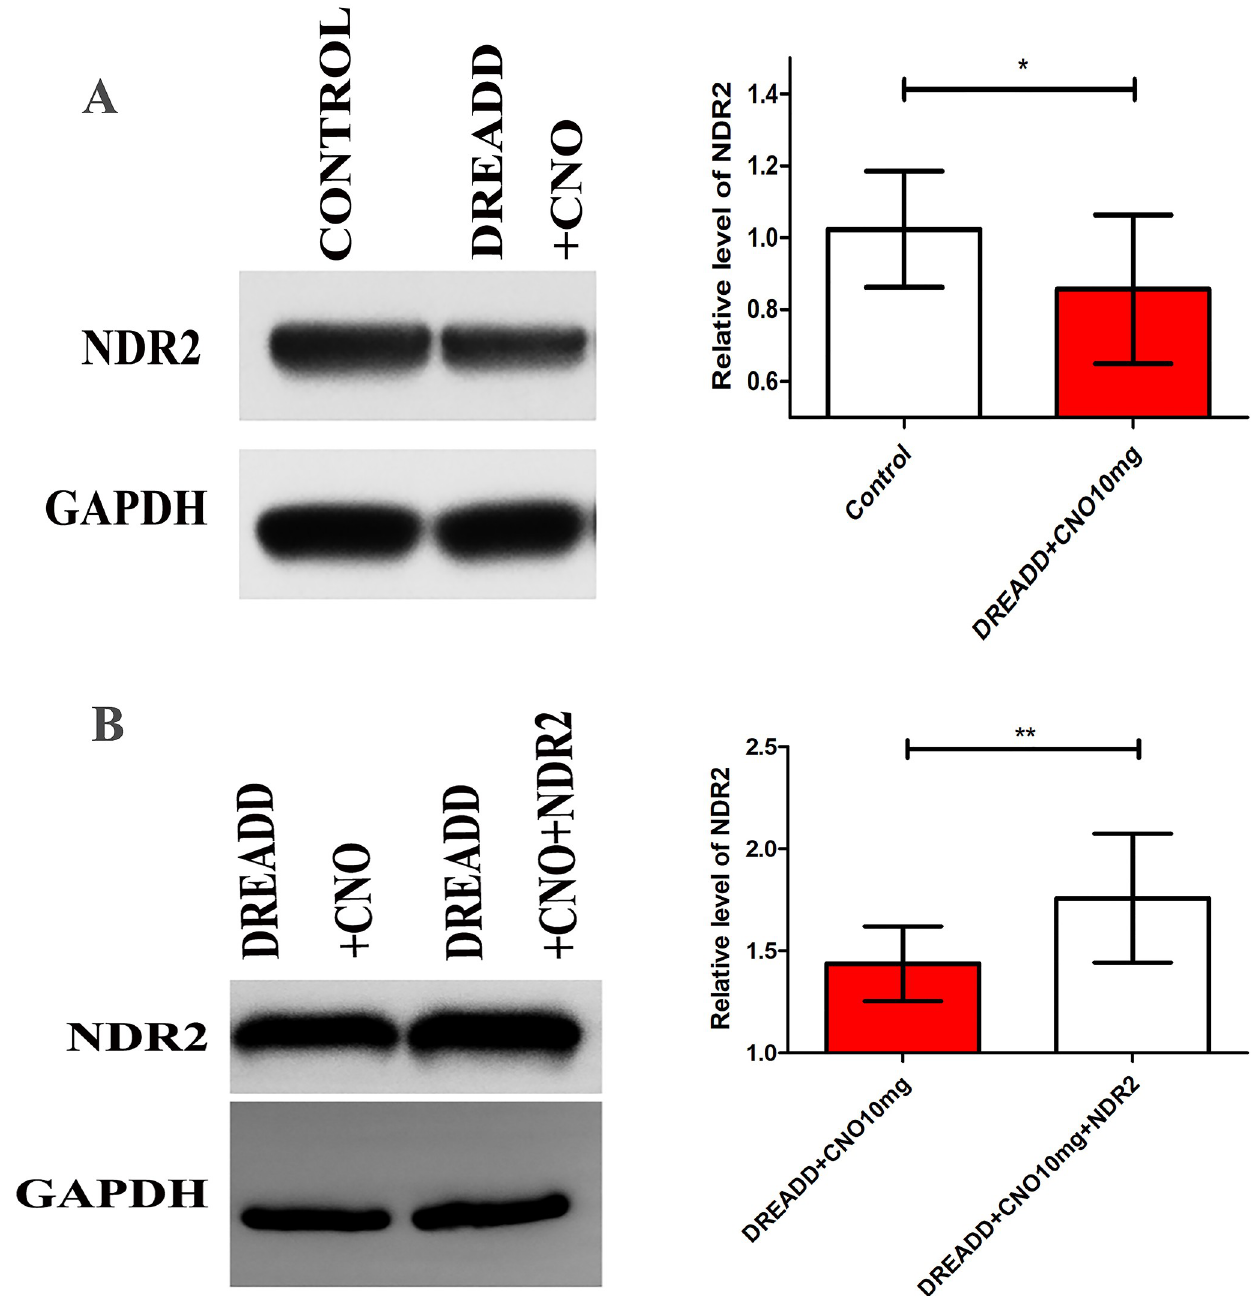
Fig 4. NDR2 expression in control, DREADD+CNO and DREADD+CNO+NDR2 groups by Western blot analysis. A, The level of NDR2 in DREADD +CNO group (n = 4) was decreased compared with that in control group (n = 4, Mann-Whitney test): B, The level of NDR2 in DREADD+CNO+NDR2 group (n = 4) was increased compared with that in DREADD+CNO group. CNO, clozapine N-oxide. All data represent the mean ± SD. * indicates P < 0.05, ** indicates P < 0.01.